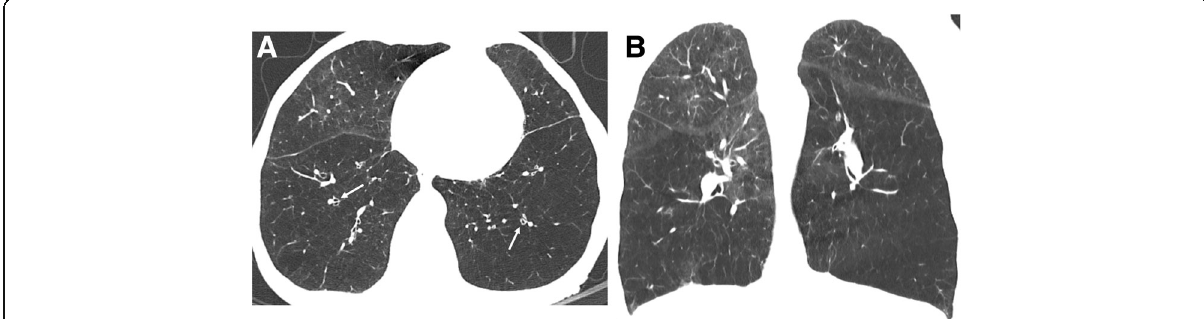
Fig. 6 PLE in a 51-year-old man with alpha-1 antitrypsin deficiency. a Axial and b coronal CT images show hyperinflation and lower lobe predominant emphysema, involving the entire secondary pulmonary lobules. Bronquial wall thickening is also depicted